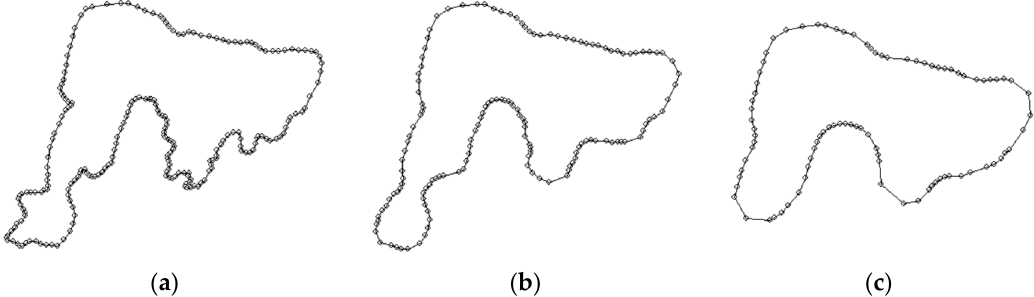
Figure 9. ( a ) Area limited by a polygon, number of vertices—215; ( b ) Area limited by a polygon, number of vertices—142, radius of generalization (modal value × MSCF)—14 m × 1.6 = 22 m; ( c ) Area limited by a polygon, number of vertices—89, radius of generalization (modal value × MSCF)—25 m × 1.6 = 40 m.